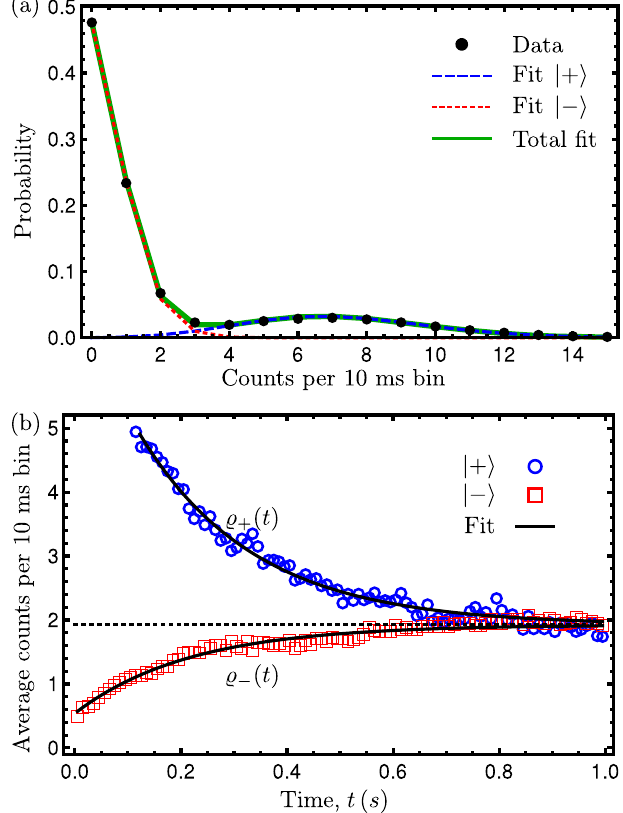
FIG. 10. (a) Histogram of photon counts per 10-ms time bin (black dots). The solid green curve is a fit to a mixture of Poisson distributions, Eq. (E1). The dashed blue and dotted red curves are the Poisson distributions conditioned on states jþi and j − i , ≈ 720 Hz and γ ≈ 50 Hz from the respectively. We extract γ − þ means of the conditional distributions. (b) Average photon counts per 10 ms, ϱ ð t Þ , for trajectories postselected on the initial states (cid:3) jþi (blue circles) and j − i (red squares). The solid black lines are a simultaneous fit of ϱ ð t Þ and ϱ − ð t Þ to Eq. (E3). From the fit, we þ ≈ 3 . 6 Hz and Γ ≈ 0 . 98 Hz. The horizontal dotted extract Γ − þ black line is the steady-state average B obtained from the fit to Eq.